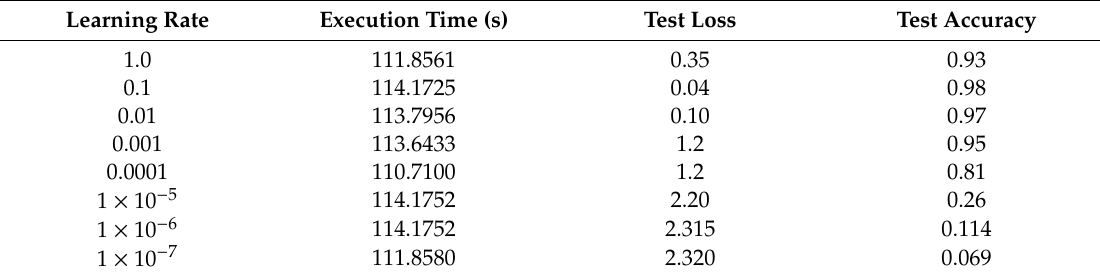
Table 16. E ff ect of learning rate on multilayer perceptron.